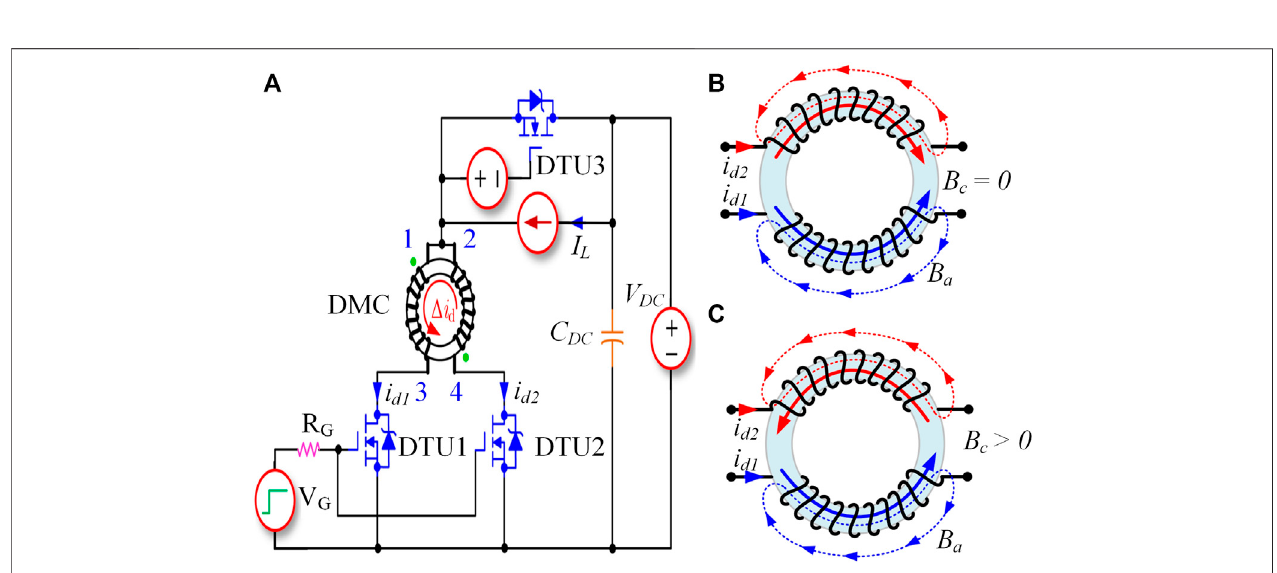
FIGURE 13 | (A) Schematic diagram for imbalance current suppression by DM choke (B) Magnetic fl ux density ( B c ) under balanced current i d1 (cid:2) i d2 (C) B c under imbalance current